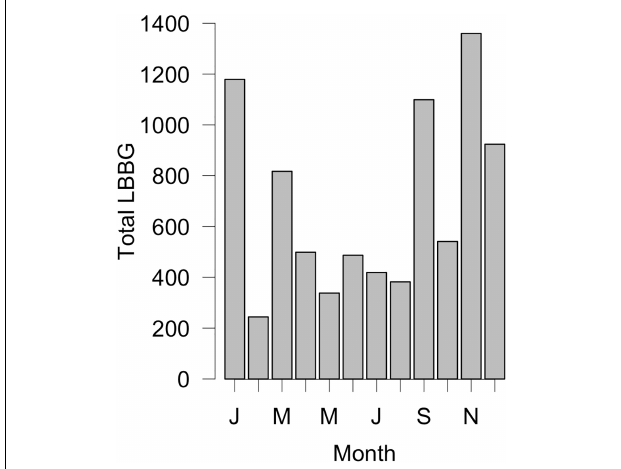
FIGURE 2 | Monthly totals of LBBG recorded in Massachusetts from the journal Bird Observer between the years 1971–2018. LBBG are more commonly seen from September to